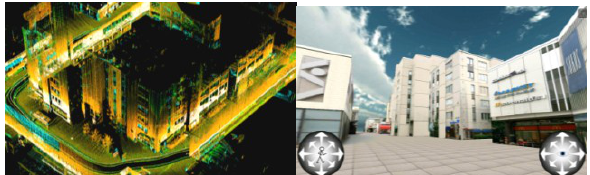
Figure 3. Left: Three-dimensional point cloud from Tapiola, Finland. Right: Photorealistic model of Tapiola processed out from the MLS data and digital imagery (Model image courtesy A. Jaakkola).